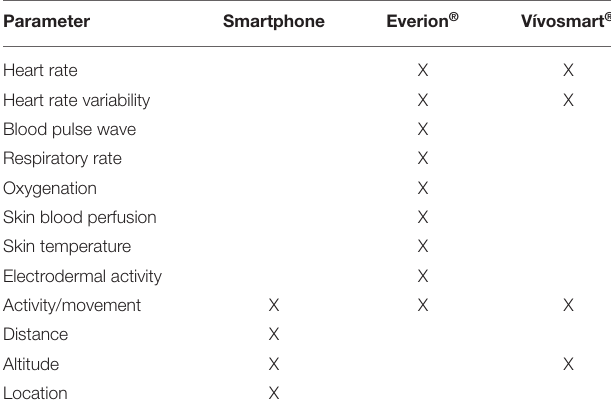
TABLE 3 | Digital parameters for Ecological Momentary Assessment (EMA) and Digital Phenotyping (DP). Parameter Smartphone Everion